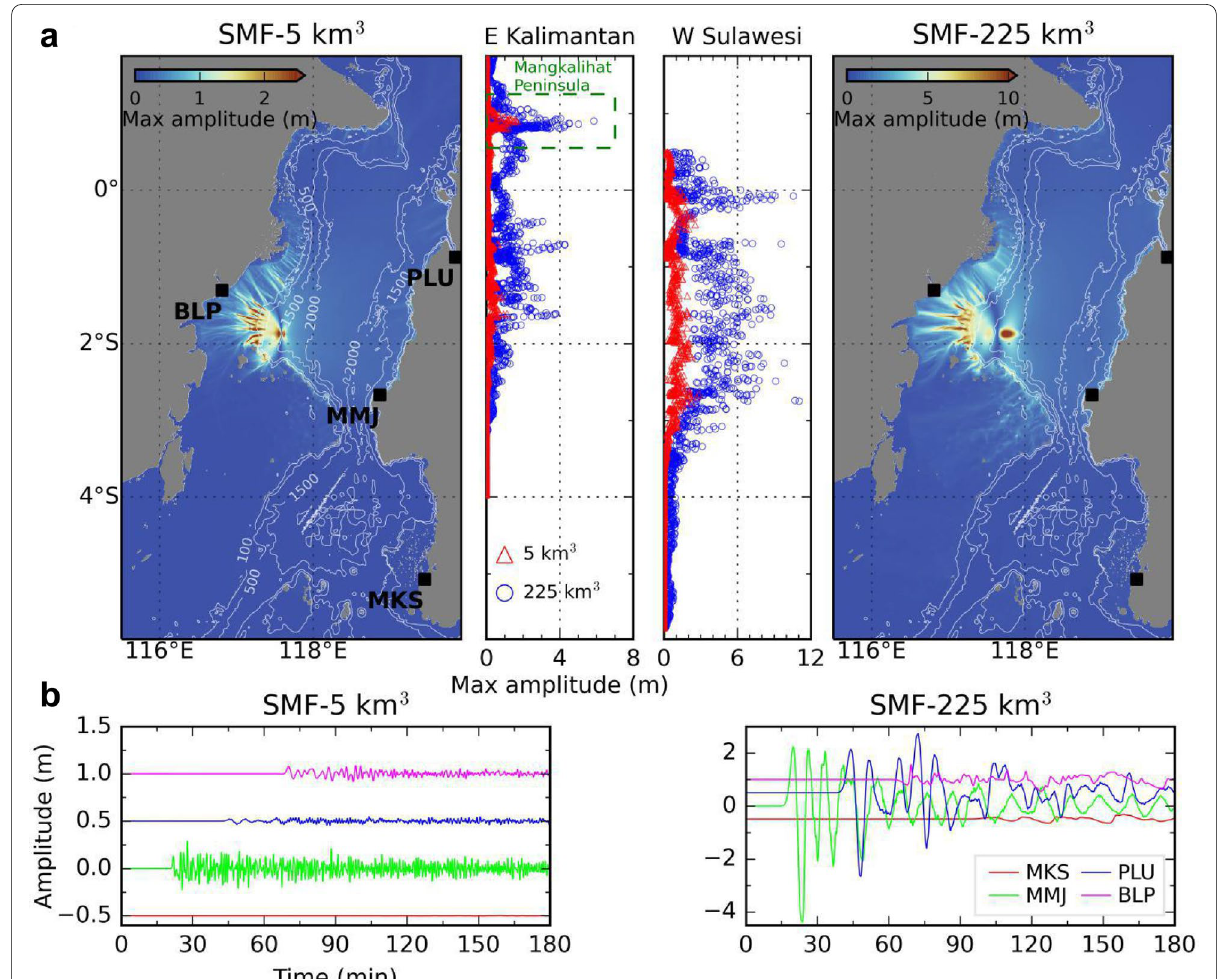
Fig. 6 Result of SMF-tsunami simulations in the Makassar Strait triggered by SMFs with volume of 5 km 3 and 225 km 3 . a Maximum tsunami amplitude. b Simulated tsunami waveform at four virtual gauges: BLP (Balikpapan), MKS (Makassar), MMJ (Mamuju), PLU (Palu). SMF stands